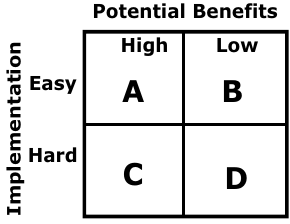
Figure 5. ABCD ranking method.